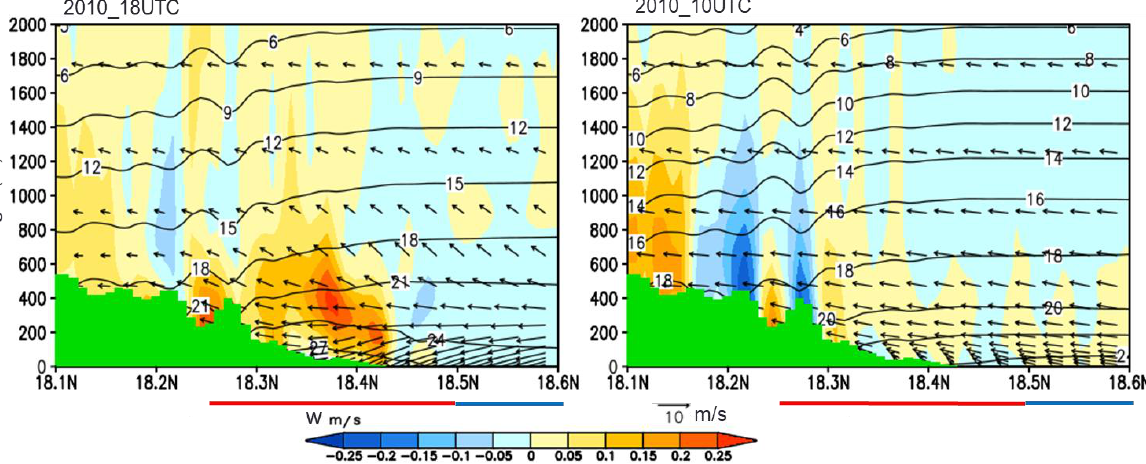
Figure 9. Temperature profile (contour lines), horizontal wind vector, and shaded contour of vertical wind (W in m/s) for mean of 18 UTC (2 PM LST) ( left ) and 10 UTC (6 AM LST) ( right ). The red line represents urban locations and blue line delineates ocean. The blue colors represent downward vertical motion, whereas the yellow – red shows upward vertical motion. The green filled solid line represents topography.